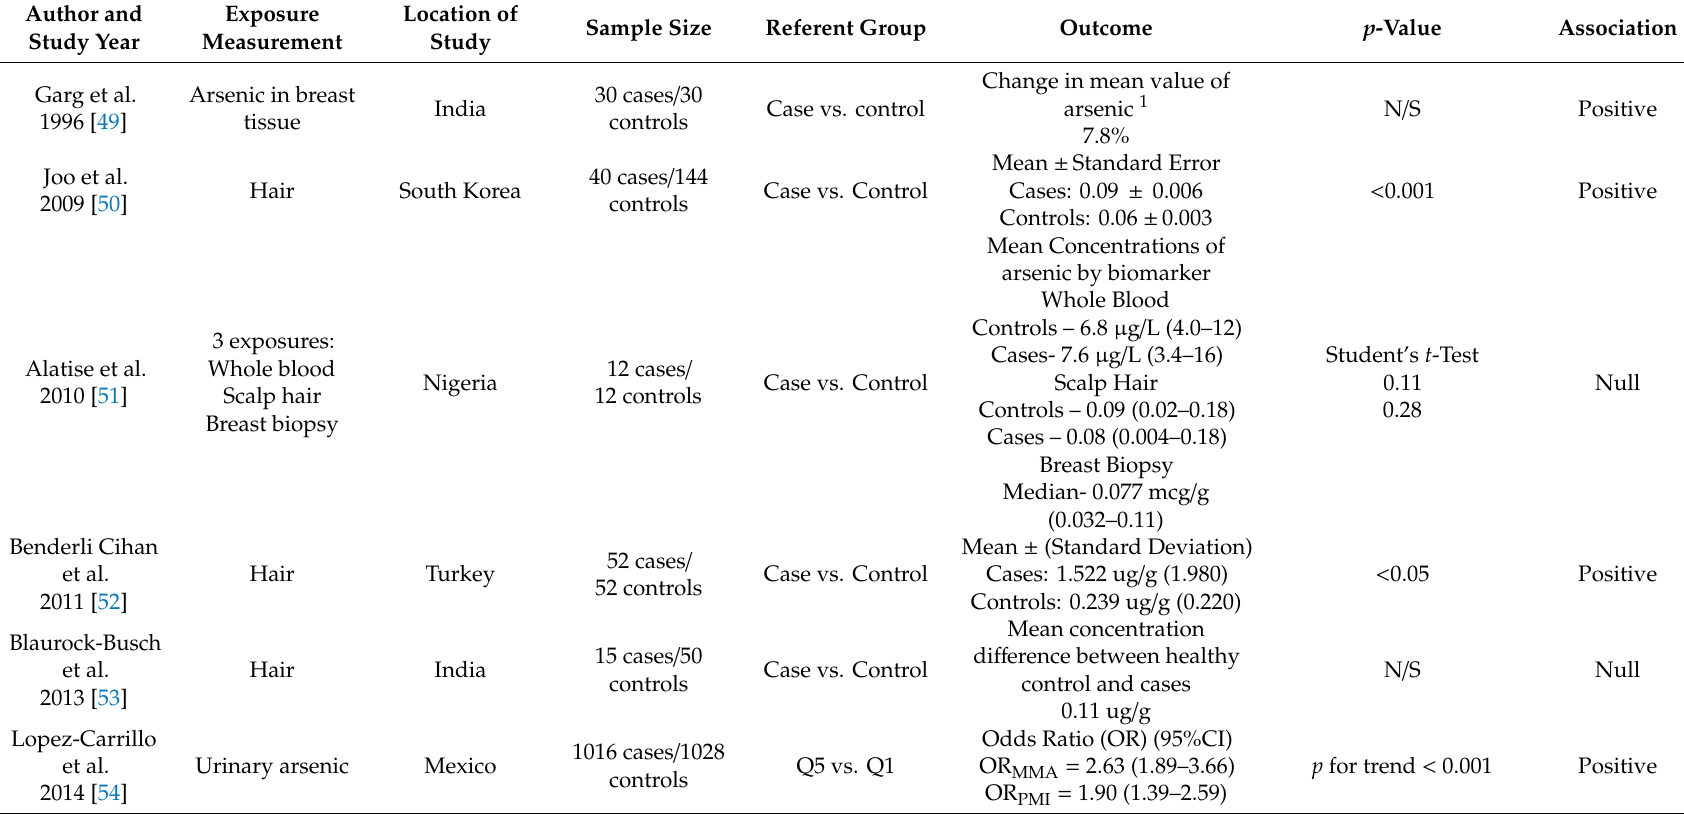
Table 3. Summary of case-control studies investigating the relationship between arsenic exposure and breast cancer